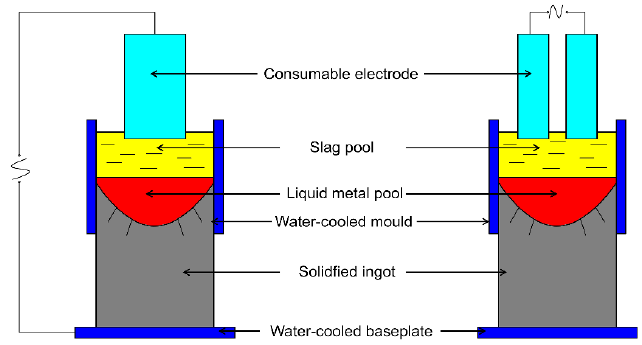
Figure 1. Schematic diagram of OE-ESR (one-electrode electroslag remelting) and TSCE-ESR (electroslag remelting with two series-connected electrodes).